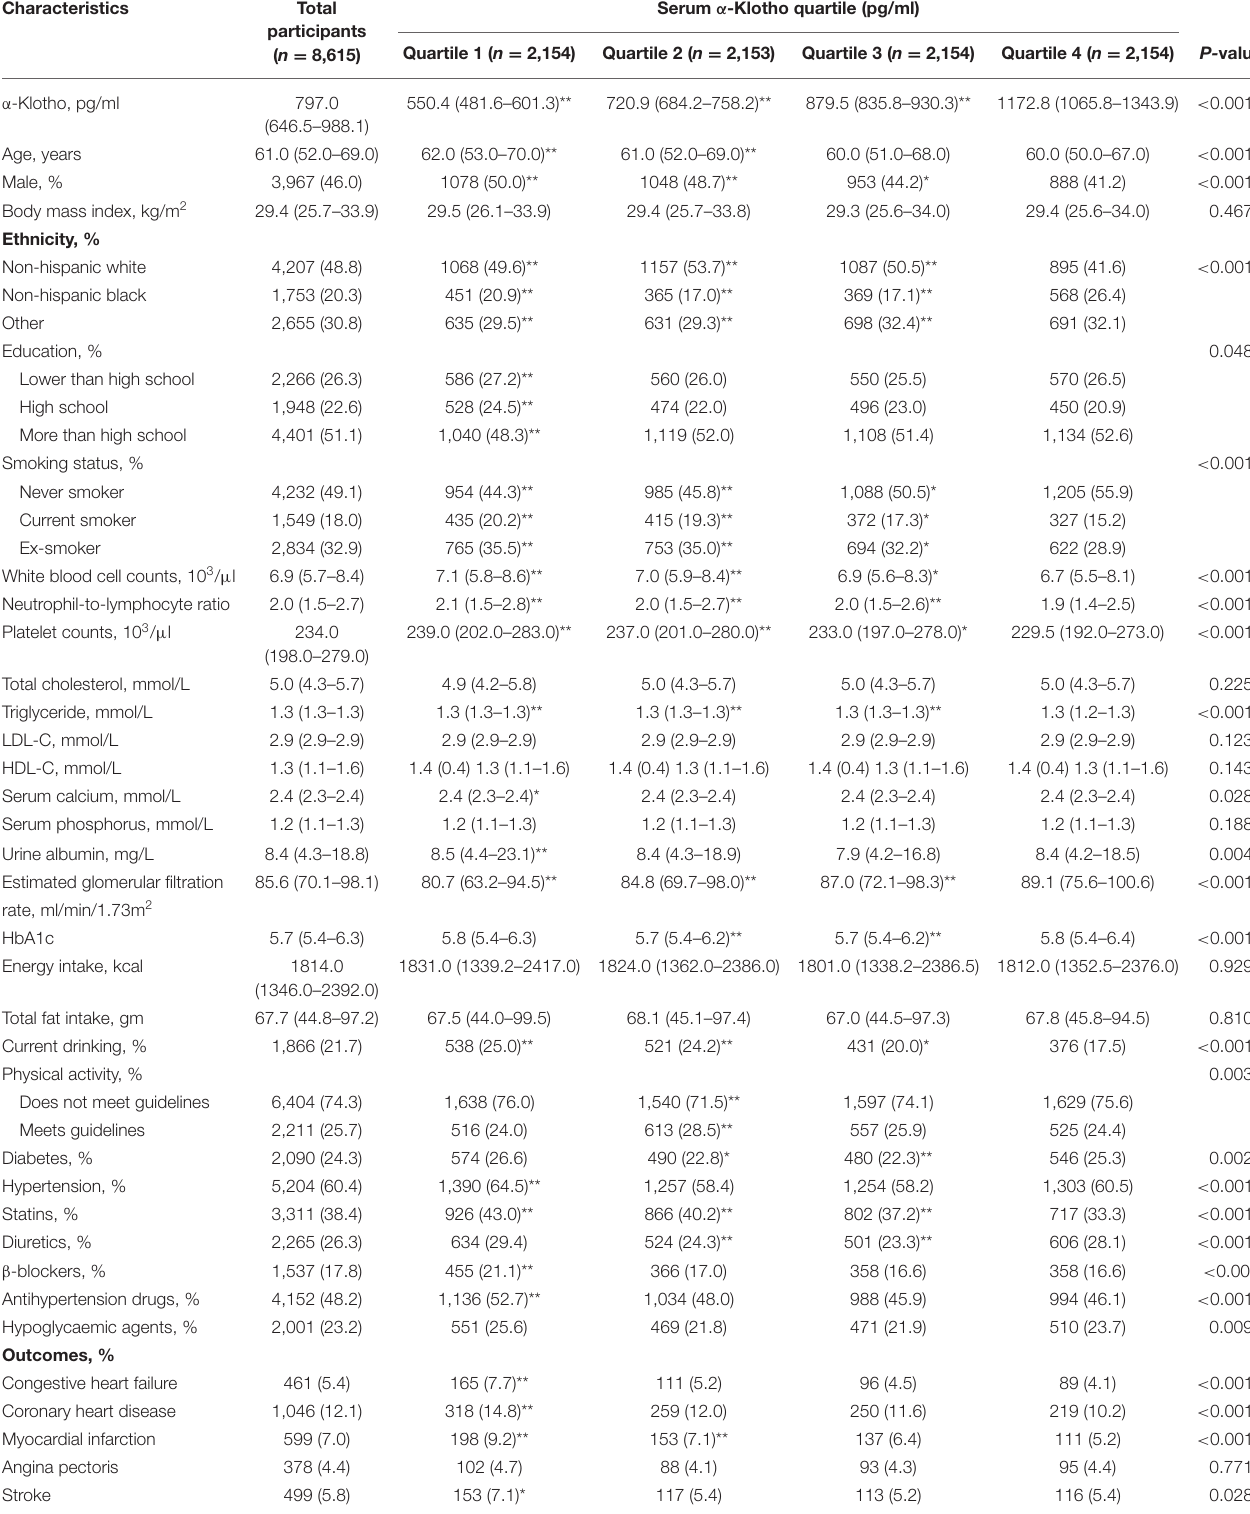
TABLE 1 | Baseline characteristics of all patients according to serum α -Klotho quartile a .